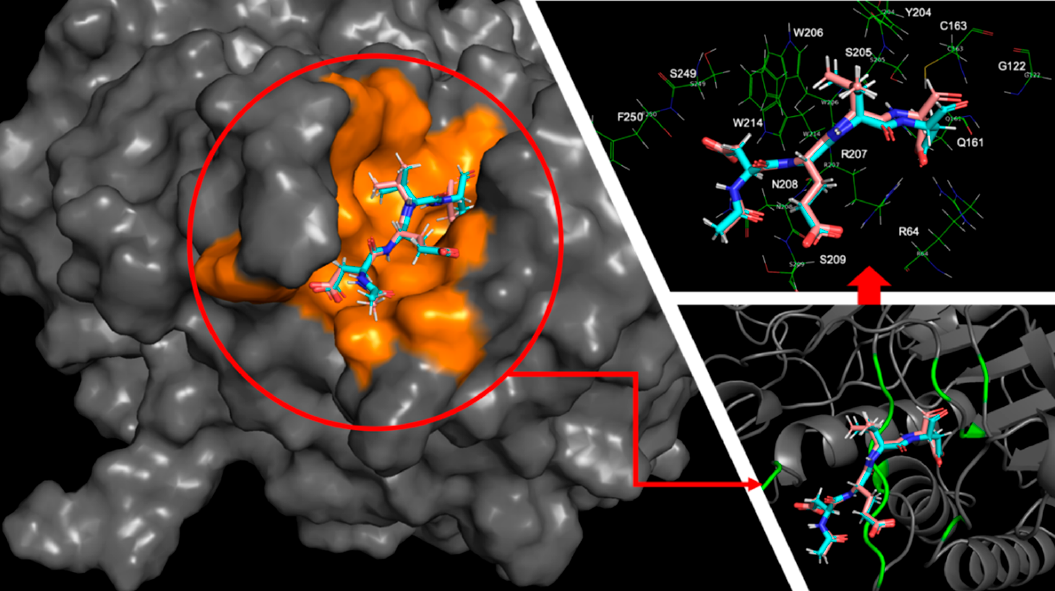
Figure 7. The global minimum docked pose (cyan) together with the crystal ligand conformation (pink) for Ac-DEVD-Cho bound to caspase-3. The orange surface on the left shows the area of interaction interface at the caspase-3 binding site. The green ribbon on the bottom right shows the locations of the residues having close contact (within 3 Å) with the global minimum docked pose. All residues having close contact with the global minimum Ac-DEVD-Cho pose are shown in the picture on the top